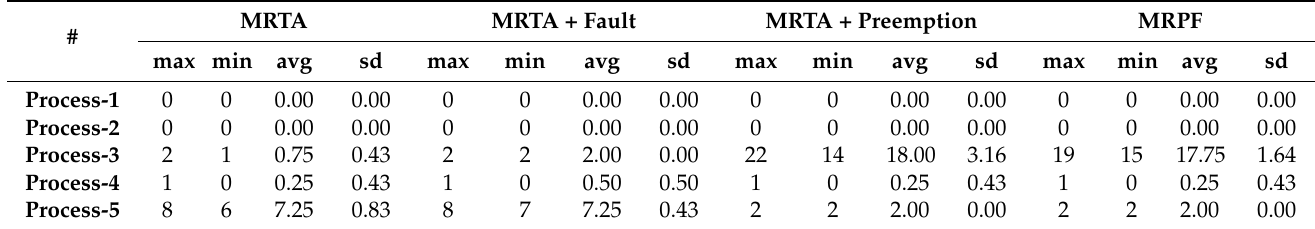
Table 7. Total ticks delay information.